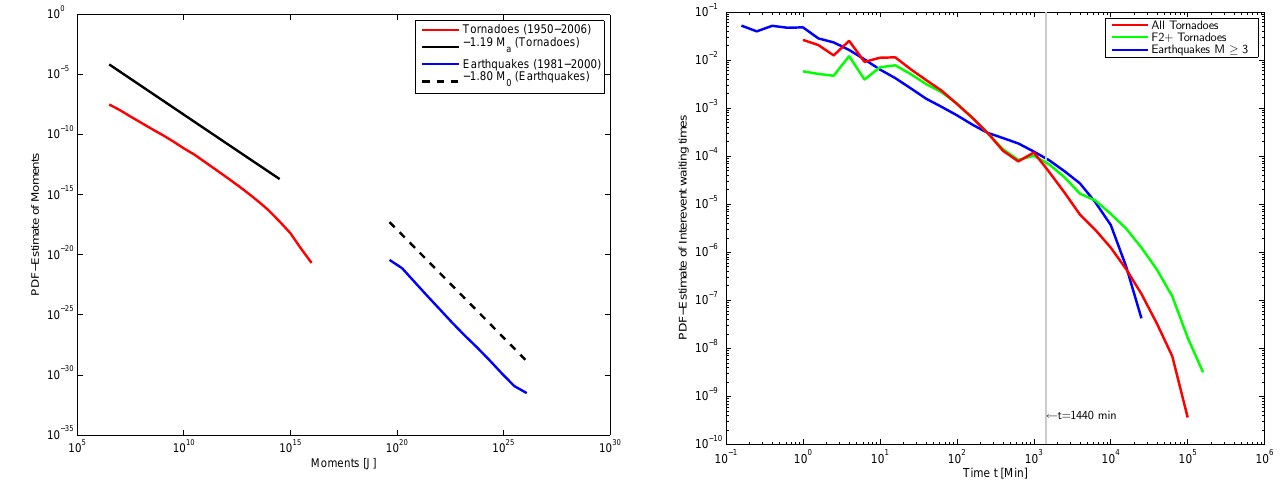
Fig. 2. Interevent waiting times: Comparison of the probability den- sity distributions of earthquakes with magnitudes larger than or equal to 3 (1981–2000, SCSN catalogue, blue curve), all torna- does (1950–2006, USA, red curve) and tornadoes with intensities larger than or equal to F 2 ( F 2+ tornadoes, 1950–2006, USA, green curve), based on logarithmically spaced time bins with increasing bin sizes of 10 ( − 1 + 0 . 2 i) min with i ∈ [ 0 , 1 ,..., 36 ] . The time line of 1440 minutes (equal to 1 day) is highlighted by the grey vertical line in the